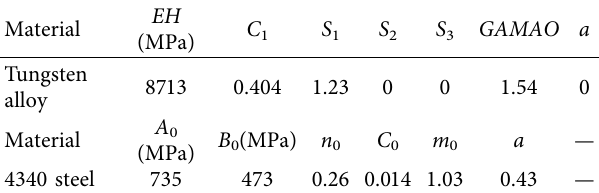
Table 2: Material model